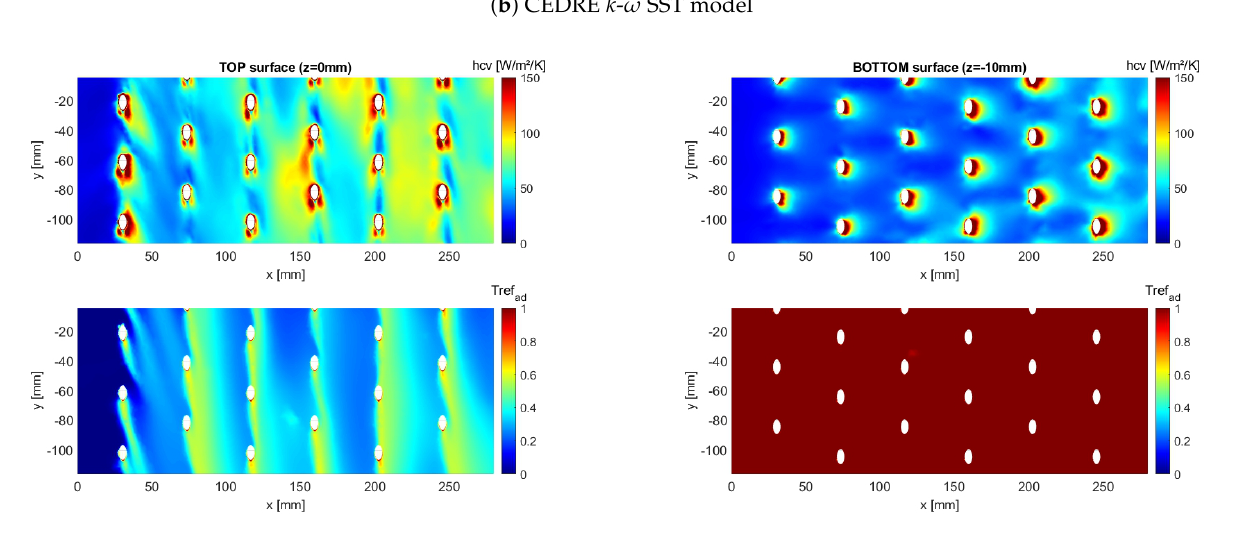
Figure 24. Experimental and numerical HTC and adiabatic wall temperature maps on top and bottom surface of multiperfo- rated